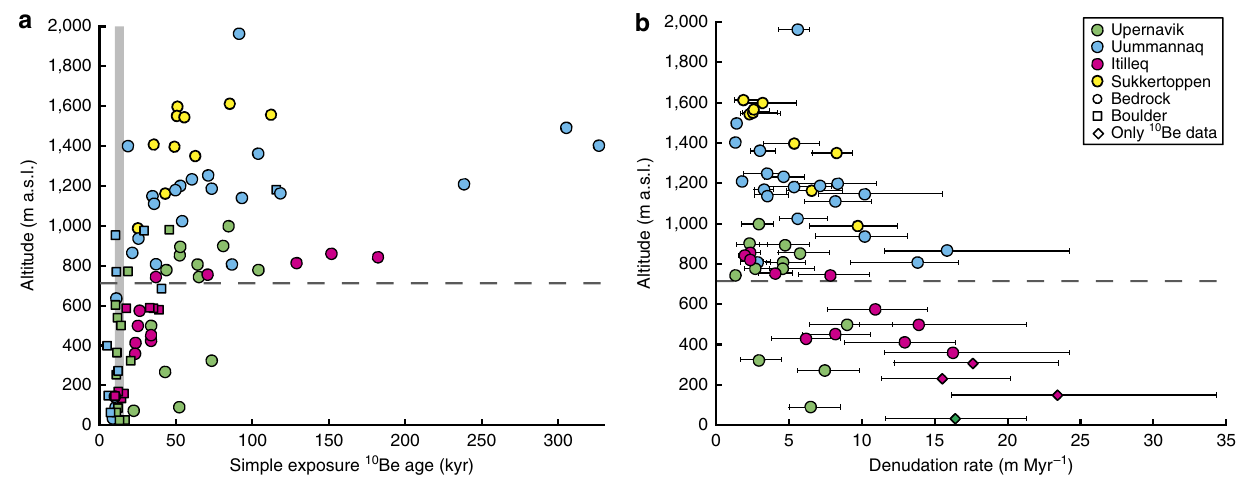
Figure 2 | Simple exposure 10 Be ages and long-term denudation rates as a function of altitude. ( a ) Simple exposure 10 Be ages tend to increase with elevation. Above a certain threshold (dashed line), all bedrock samples contain a cosmogenic signal inherited from periods before the most recent glaciation. The grey zone marks the limit used to constrain the timing of the Holocene deglaciation (10–16kyr) for all sites (see ‘Methods’ section). 10 Be ages are calculated using Cronus Version 2.3 (ref. 45) and the Lal (1991)/Stone (2000) scaling scheme 40,41 . ( b ) Total denudation rates over the last 1Myr based on application of the MCMC approach to samples with a simple exposure 10 Be age above 20kyr and a 26 Al/ 10 Be ratio below 7.5. All three sites in west Greenland show a clear trend of decreasing denudation rate with increasing elevation. Diamonds represent samples from the same previous studies, but with information from 10 Be only (that is, no 26 Al data were available). The rates of denudation associated with these samples have larger uncertainties. Error bars are defined as the first and third quartiles of the 200,000 iterations per